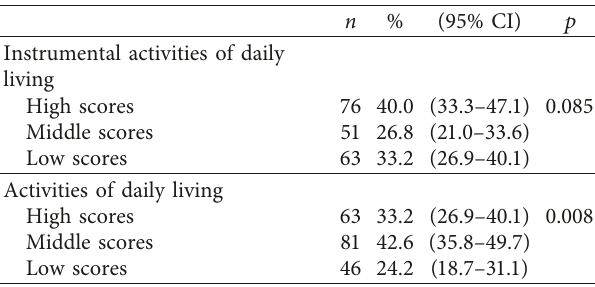
Table 2: Distribution of participants according to their obtained functionality score ( n 190). (cid:31)